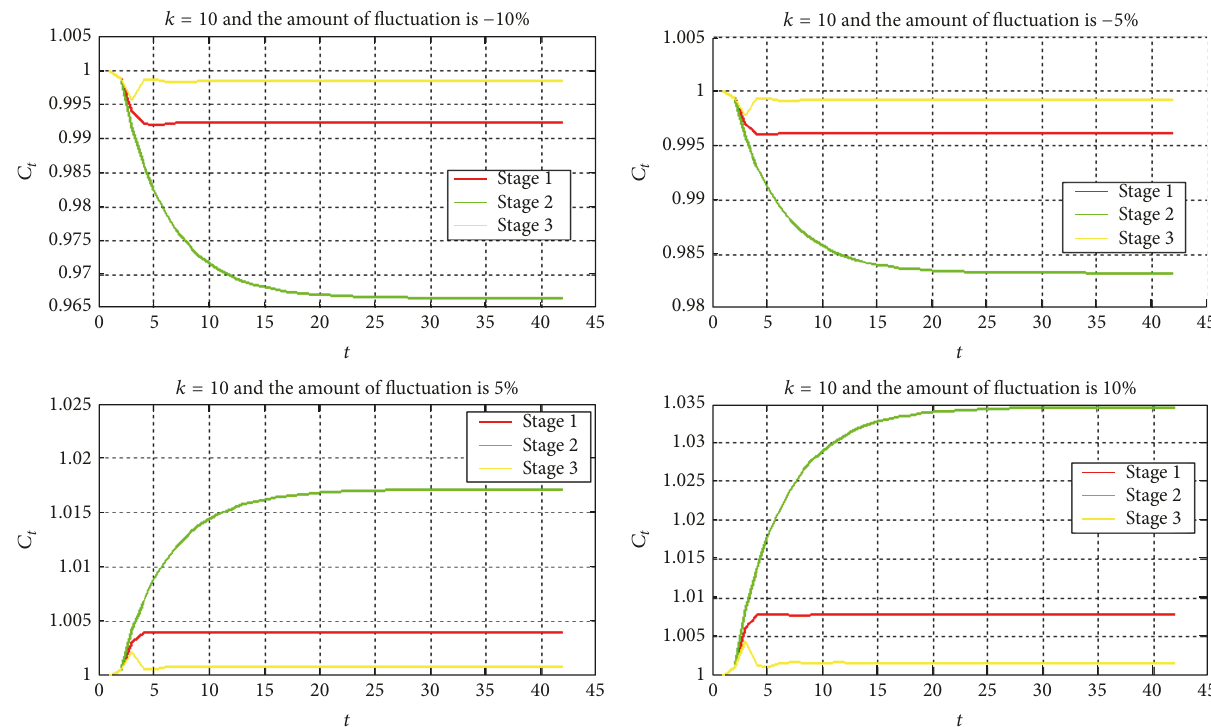
Figure 6: Influence of the initial fluctuation on network stability when 𝐾 = 10